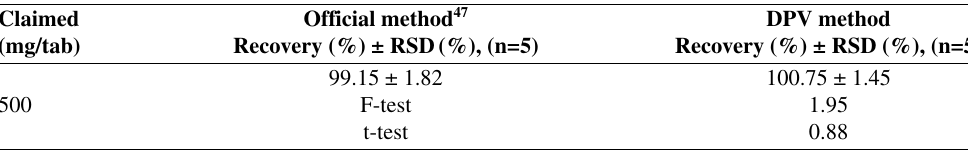
Figure 10: The effect of changing the concentration of MET, using differential pulse mode at PYCPE in BR buffer (pH 2.0), T sec and scan rate of 20 mV/s. The inset: the relation between MET concentration and the current responses.